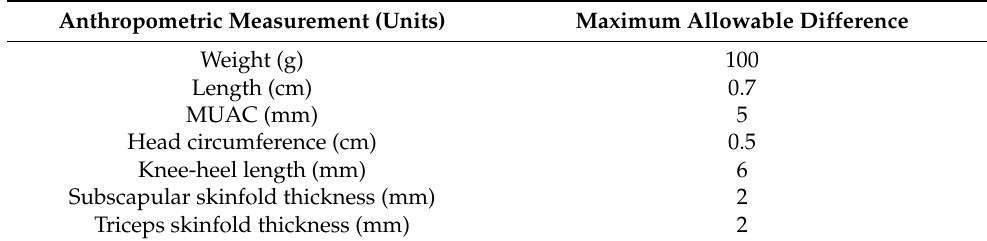
Table A1. Pre-set maximum allowable differences of various anthropometric measurements. Anthropometric Measurement